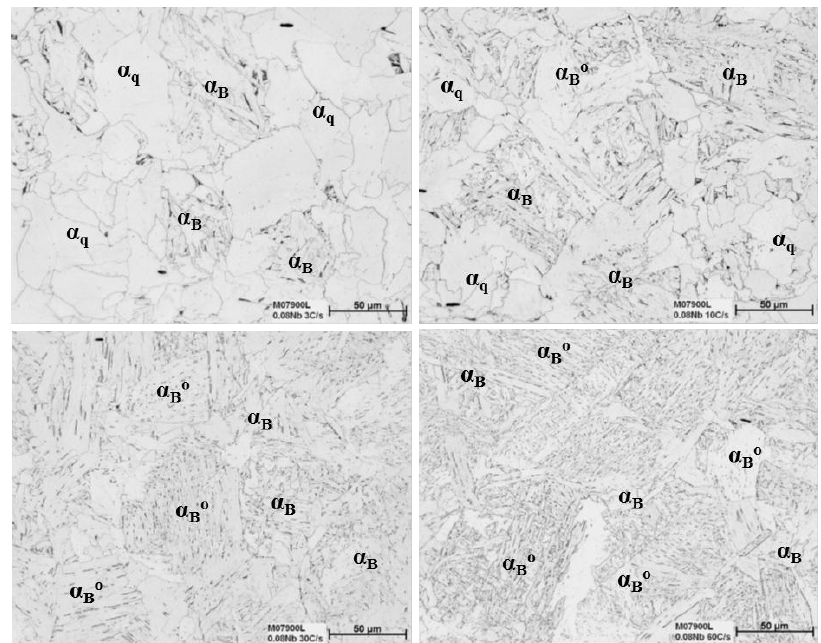
Figure 10. Optical microstructures for 0.08% Nb UCS flat dilatometer samples cooled at ( a ) 3 °C/s α q + α B , ( b ) 10 °C/s α q + α B + ~α B °, ( c ) 30 °C/s α B + α B °, and ( d ) 60 °C/s α B + α B